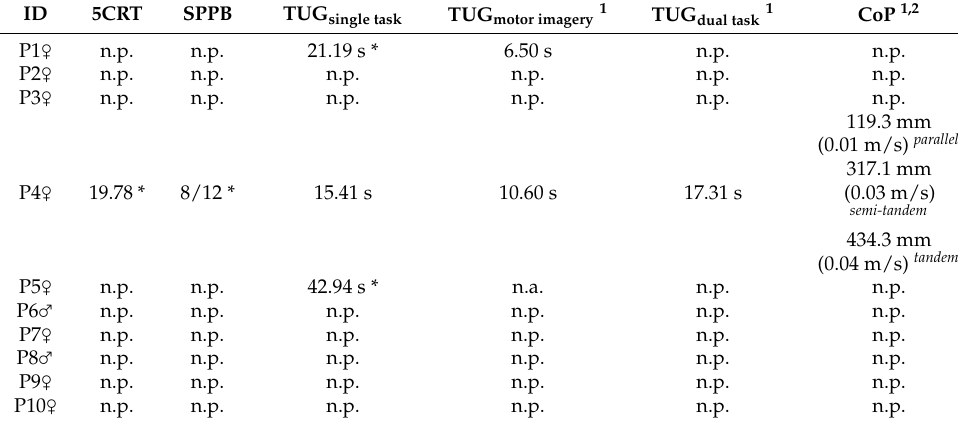
Table 5. Secondary outcomes.